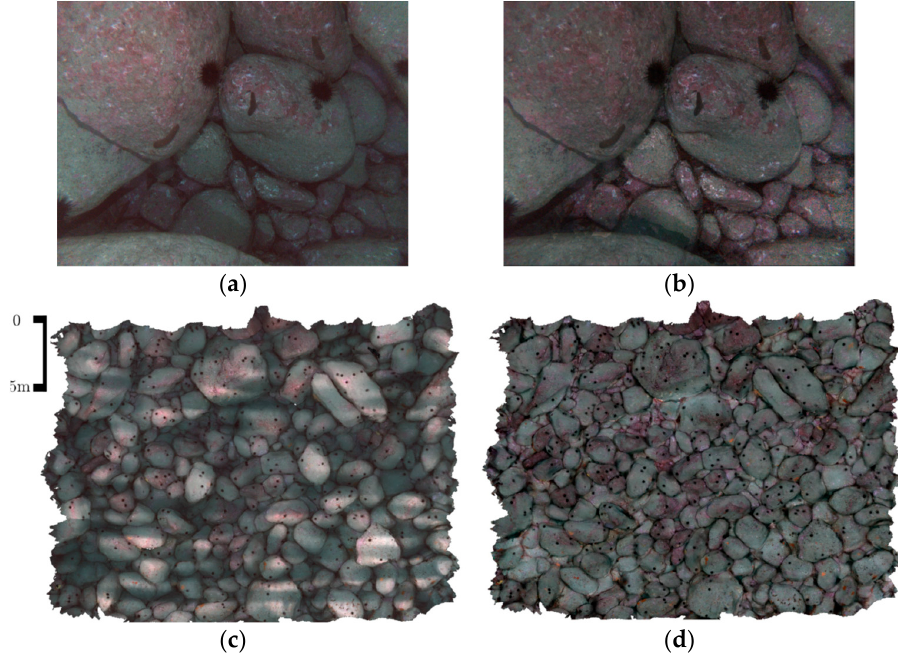
Figure 4. ( a ) Restored image using a non-depth-based approach, ( b ) image with water attenuation compensation, ( c ) 3D texture of the scene using non-depth-based corrected textures and ( d ) 3D texture of the scene with water attenuation corrected textures. Images from [32].